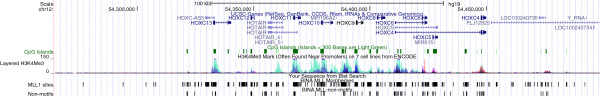
Localization of CGI and MLL1 morphemes in DNA segments encompassing human HOXC locus. Horizontal green bars mark the position of CGIs. Track-labeled “MLL1 sites” marks morpheme positions; “non-motifs” mark the position of sequences not found in results of SELEX assays [24]. Track-labeled “Layered H3K4me3” shows the position of H3K4me3 marks [59].